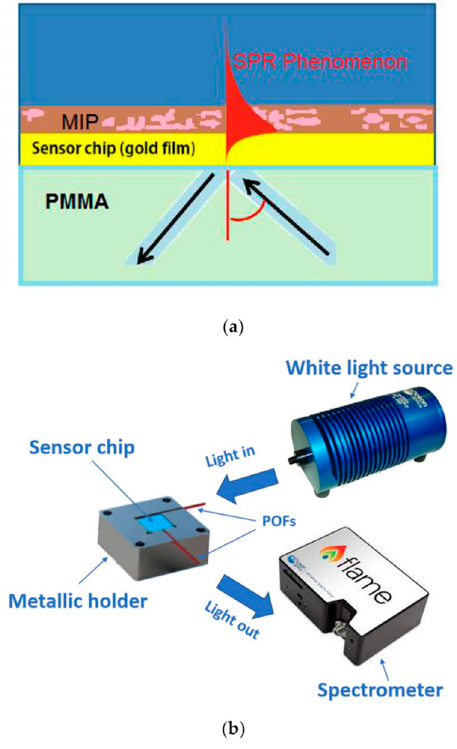
Figure 3. ( a ) The SPR sensor chip’s cross-section. ( b ) Experimental setup. Reprinted from [75] with permission from Cennamo et al. permission from Cennamo et